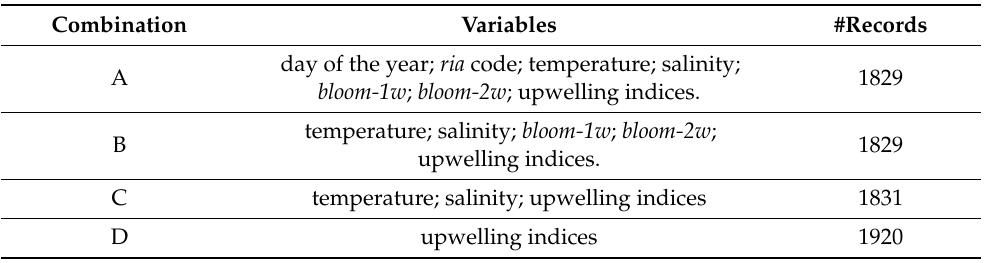
Table 2. Combinations of variables used to develop the models, and total number of records available for each